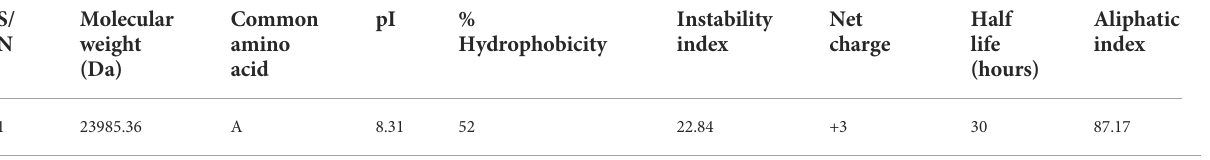
pI, Isoelectric point.